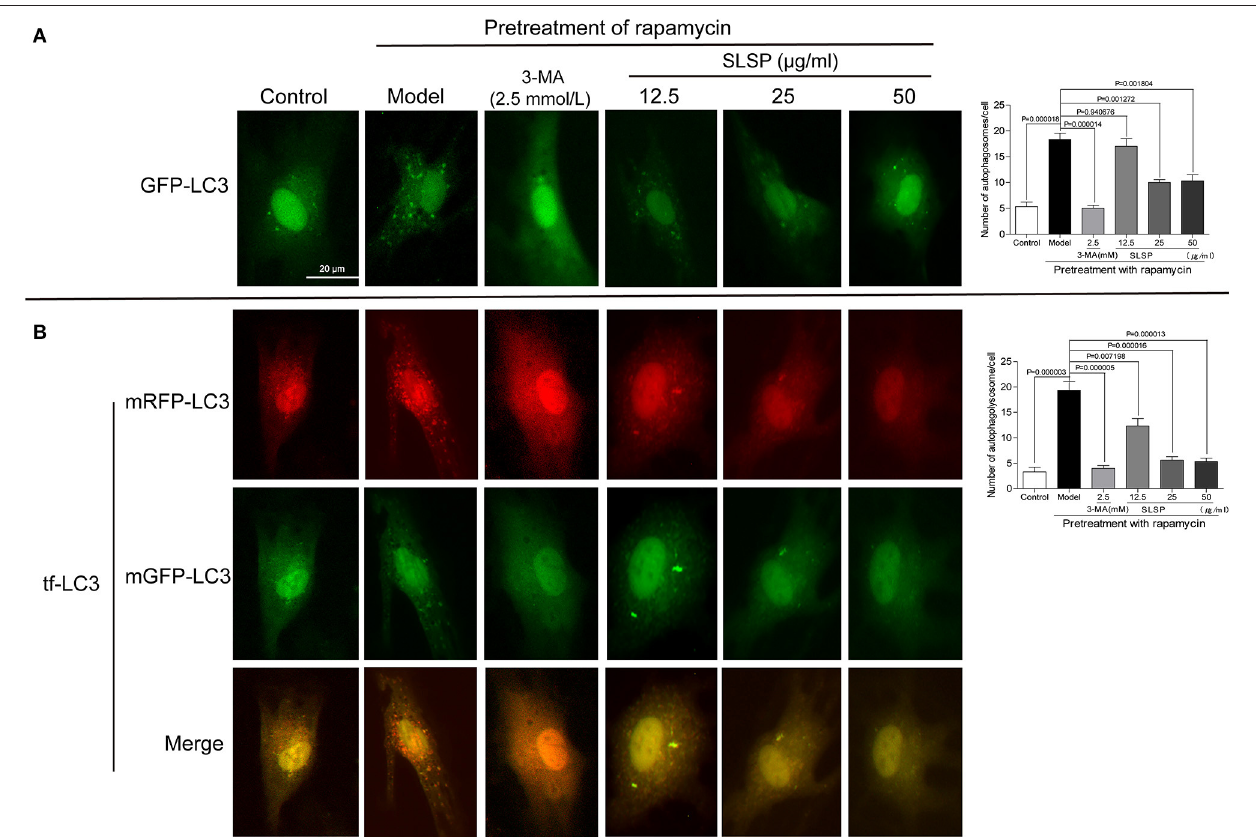
FIGURE 5 | SLSP reduced autophagosomes and autolysosomes in H9c2 cells transfected with GFP-LC3 and tf-LC3. (A) SLSP decreased autophagosomes in H9c2 cells transfected with GFP-LC3. (B) SLSP mitigated autophagosomes and autolysosomes in H9c2 cells transfected with tf-LC3. Scale bar: 10 µ m. N = 3/group.